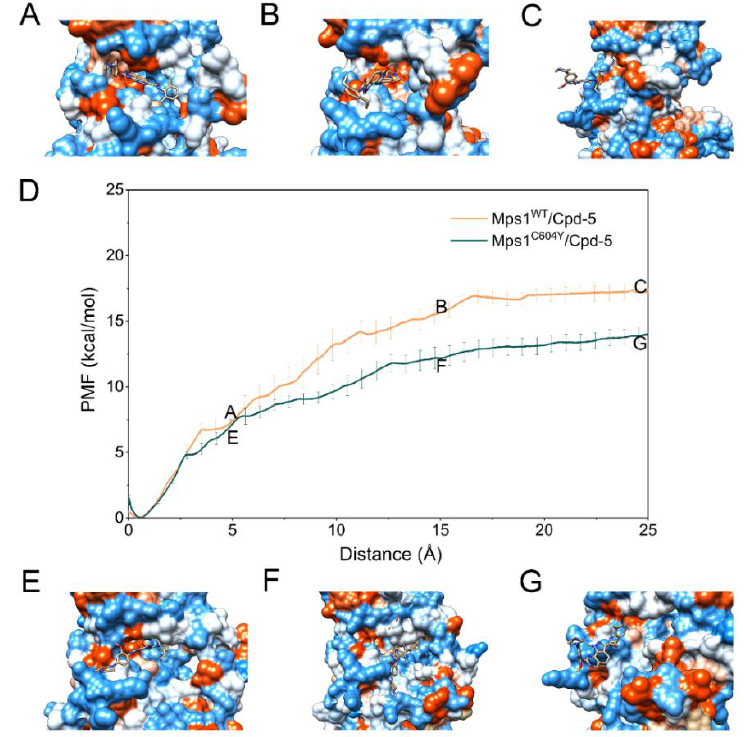
Figure 9. Alignment of the PMFs for Cpd-5 dissociate from Mps1 WT and Mps1 C604Y .